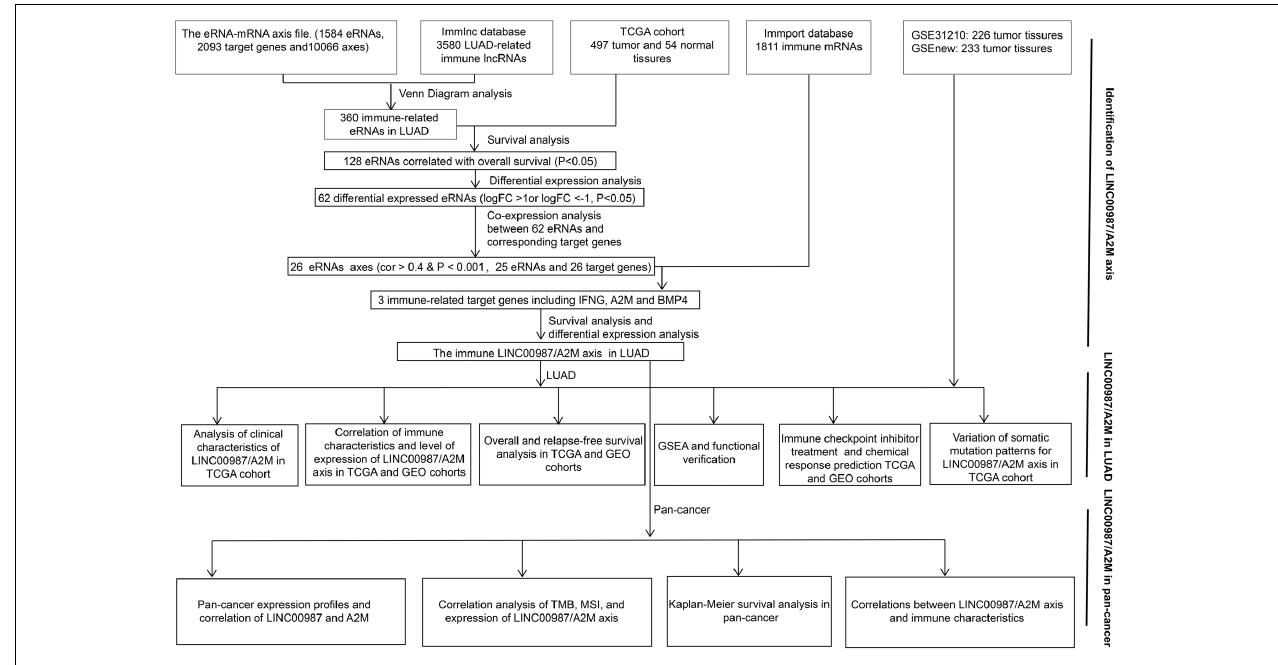
FIGURE 1 | Workflow. Workflow for the identification and verification of the immune-related LINC00987/A2M axis in LUAD and pan-cancer.